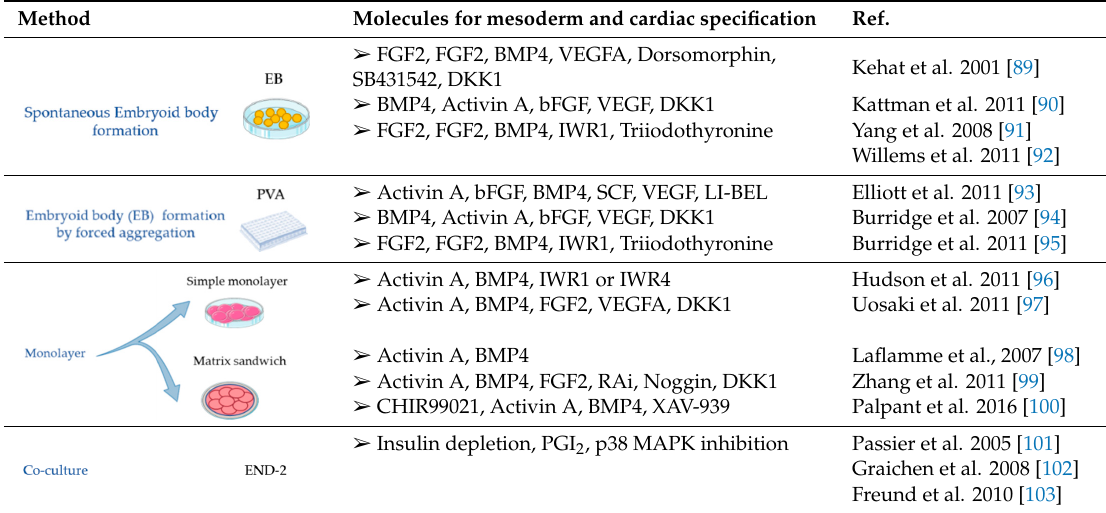
Table 1. Summary of cardiac differentiation methods.